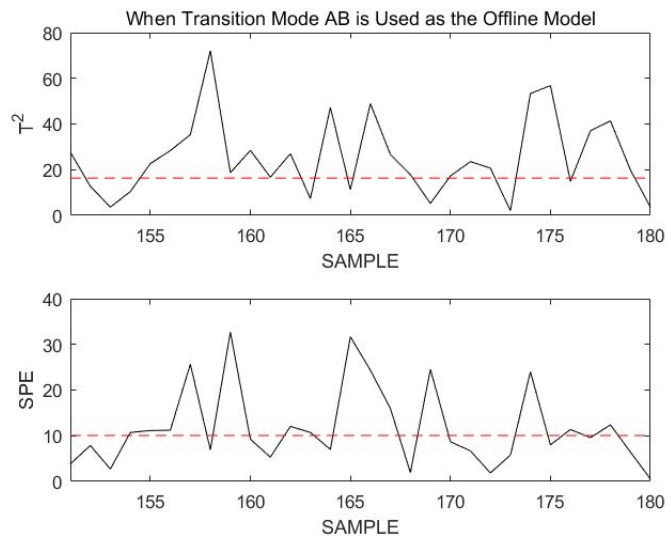
Figure 18. Monitoring 151st to 180th sample points using transition mode AB as an offline model.